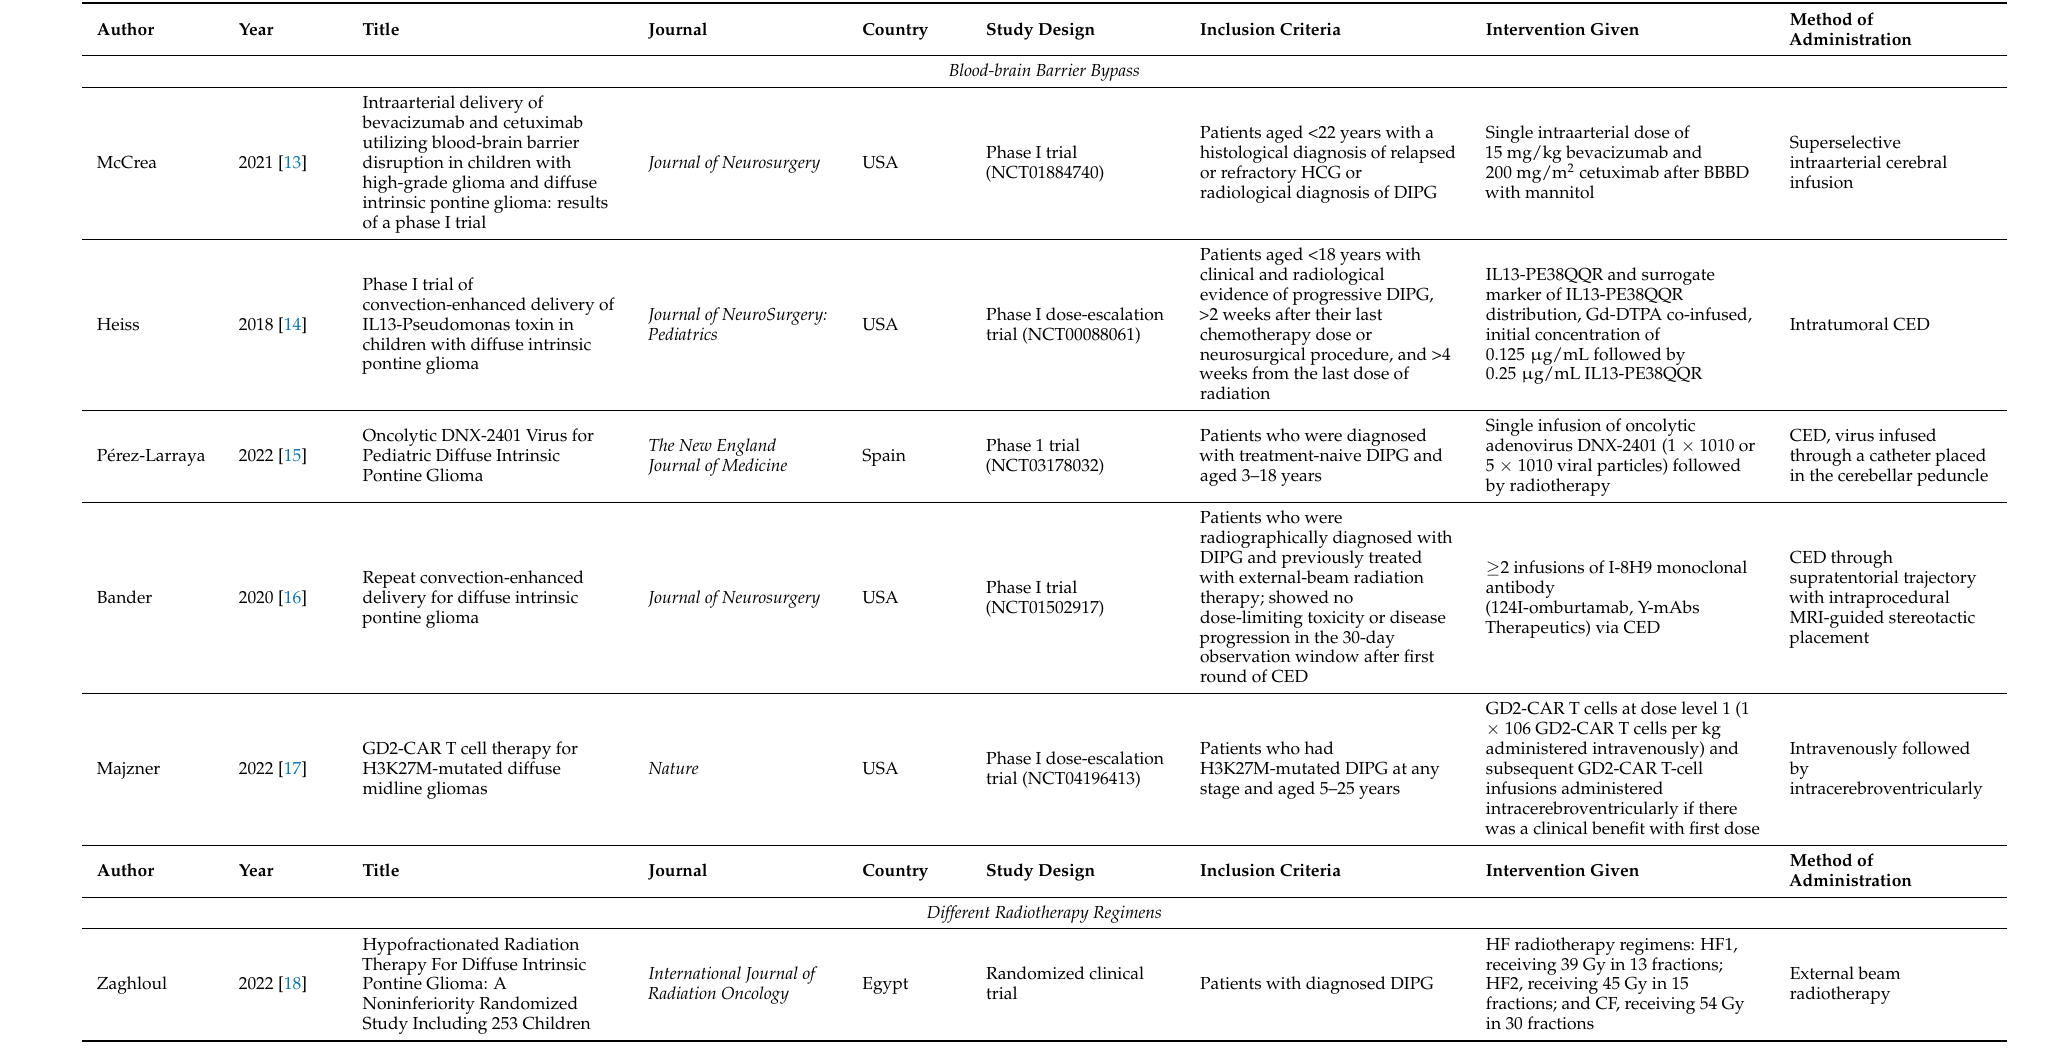
Table 1. Baseline characteristics of the trial and dosing